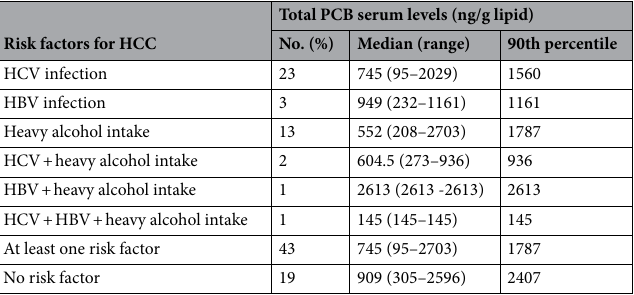
Table 3. Lipid-adjusted serum levels of total polychlorinated biphenyls (PCBs) in hepatocellular carcinoma (HCC) cases.